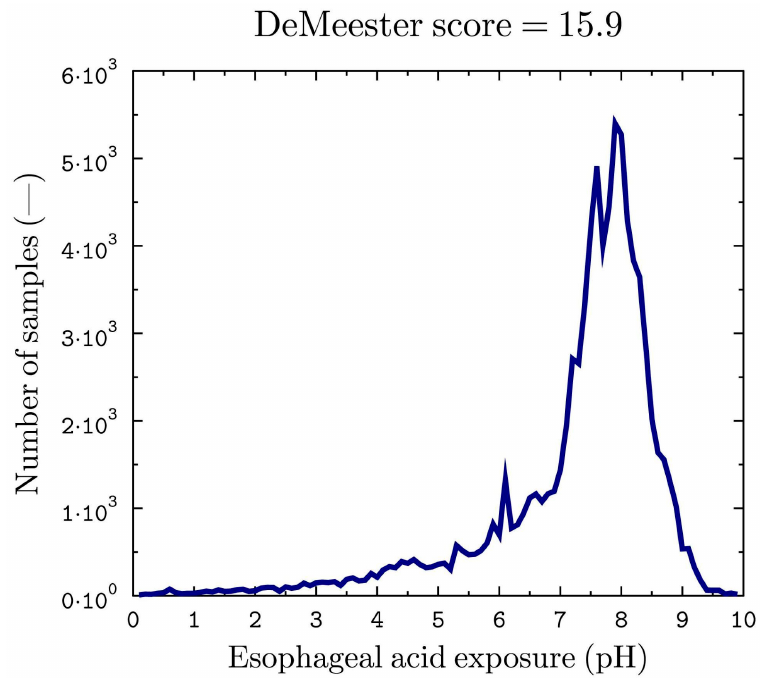
Figure 4. The final form of the signal subjected to continuous wavelet transform analysis.